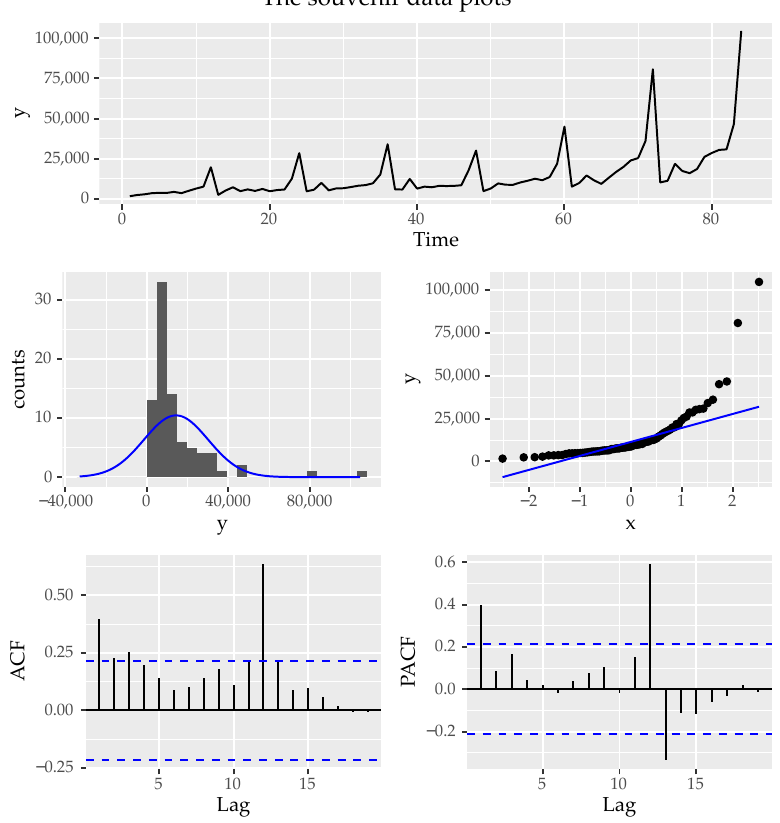
Figure 2. Diagnostic plots for the souvenir data. The upper plot shows a time-series plot, which reveals evidence of non-stationarity. The middle plots are the histogram ( middle-left ) and the quantile–quantile plot ( middle-right ), and both plots suggest that the time series process has a non-normal distribution. The lower plots show the autocorrelation